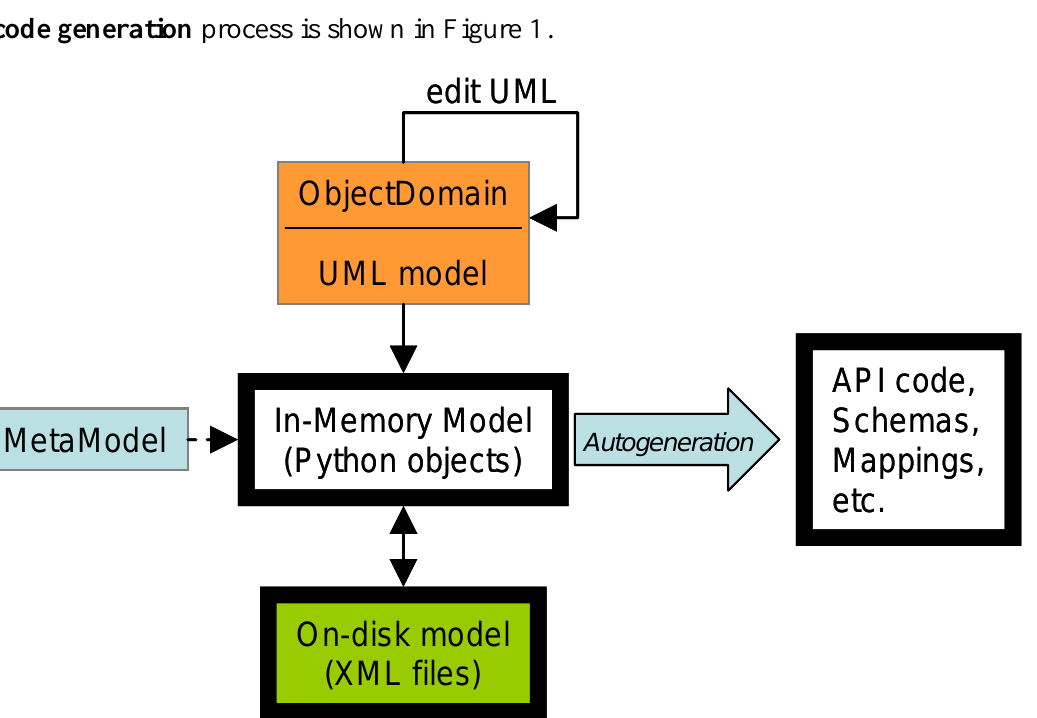
Supplementary Figure 1: Workflow for code generation. CCPN software is coloured in blue, while external software is coloured in orange. Boxes with thick black borders are files generated by the CCPN